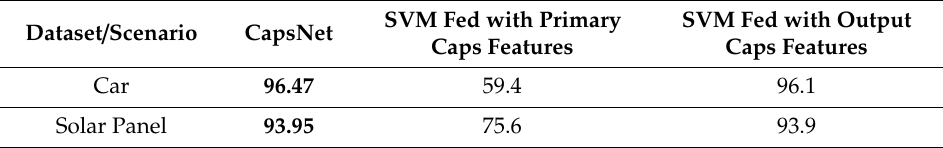
Table 8. Classification accuracies (%) obtained by the CapsNet and the support vector machines (SVM) classifier fed with features from di ff erent layers of the